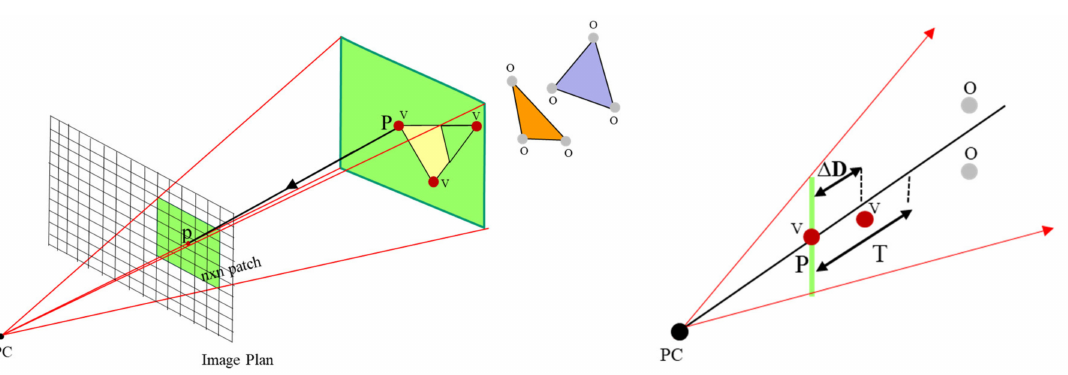
Figure 6. Visible data filtering, projection of vertex P to image plane with a grid patch centered at p, V is visible, O is